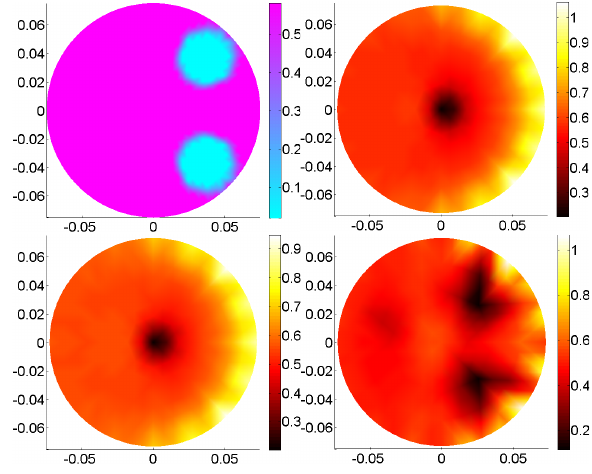
Fig.1 5: Conductivity reconstruction of the phantom with double inhomogeneity (D = 40 mm, L = 52.5 mm) near electrode No.-3 and 15 ( λ = 0.01): (a) original object, (b) image with STR, (c) image with LMR, (d) image with